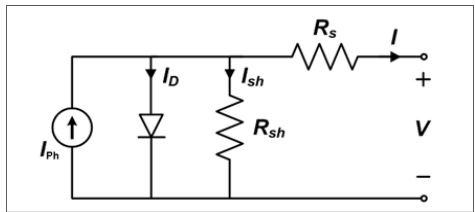
photocurrent source(